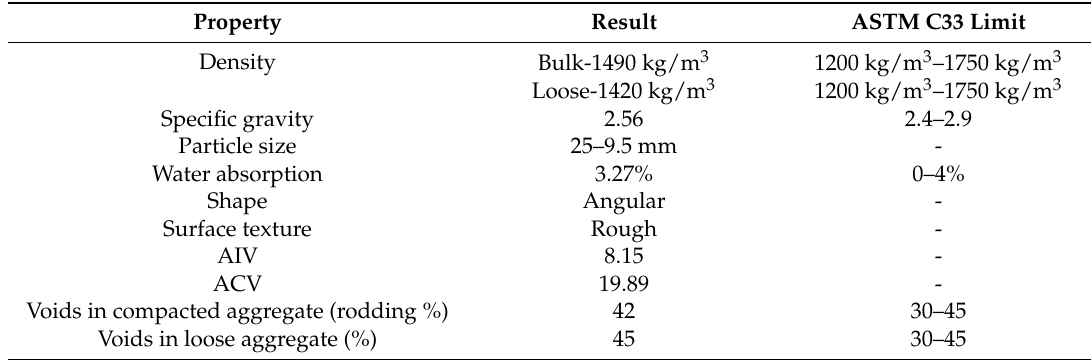
Table 5. Physical properties of coarse